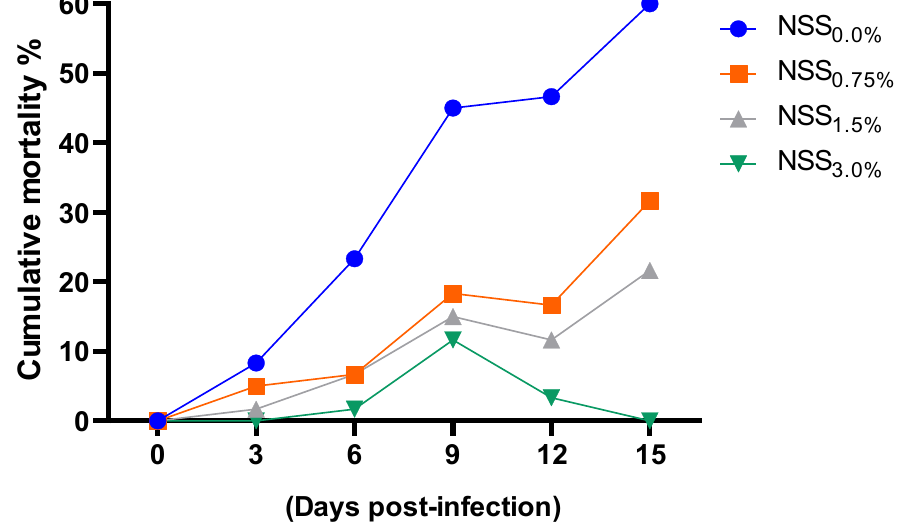
Figure 5. Effect of supplementing diets with varying levels of a microalgae mix (NSS) containing Nannochloropsis oculate and Schizochytrium and Spirulina species at equal proportions (1:1:1) for 12 weeks on the cumulative mortality percentages of Nile tilapia after challenge with Aeromonas hydrophila . Data are expressed as means ± SE. Bars with different letters denote significant differences ( p < 0.05). NSS: microalgae mix containing Nannochloropsis oculate and Schizochytrium and Spirulina species at equal proportions (1:1:1), NSS 0 . 0% : control group fed basal diet free from NSS, NSS 0 . 75% : basal diet supplemented with 0.75% of NSS, NSS 1 . 5% : basal diet supplemented with 1.5% of NSS , NSS 3 . 0% : basal diet supplemented with 3% of NSS.